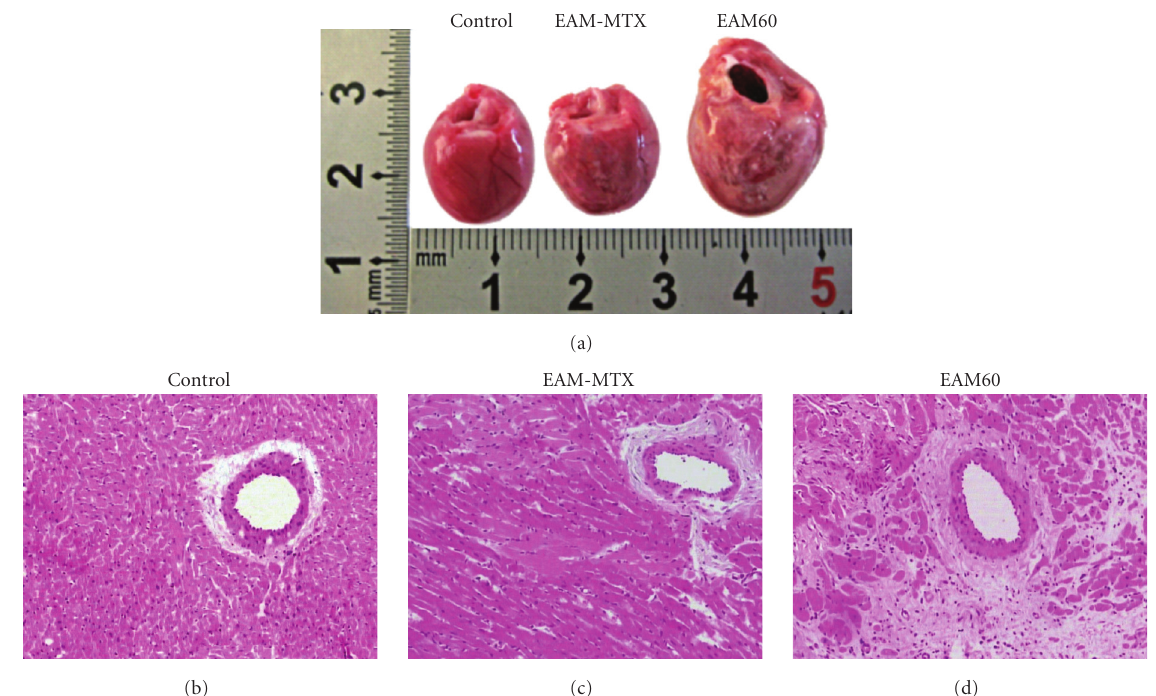
Figure 2: Macroscopic and microscopic assessment of the hearts. (a) Representative gross appearance of the heart from each group of rats. (b) Representative photomicrographs of the ventricular sections (HE staining; × 200). In hearts from the control group, myocytes is well organized. In EAM60 group, the cardiac myocytes exhibited extensive necrosis, degeneration, and disorder. MTX treatment led to a significant decrease in the size of these lesions.